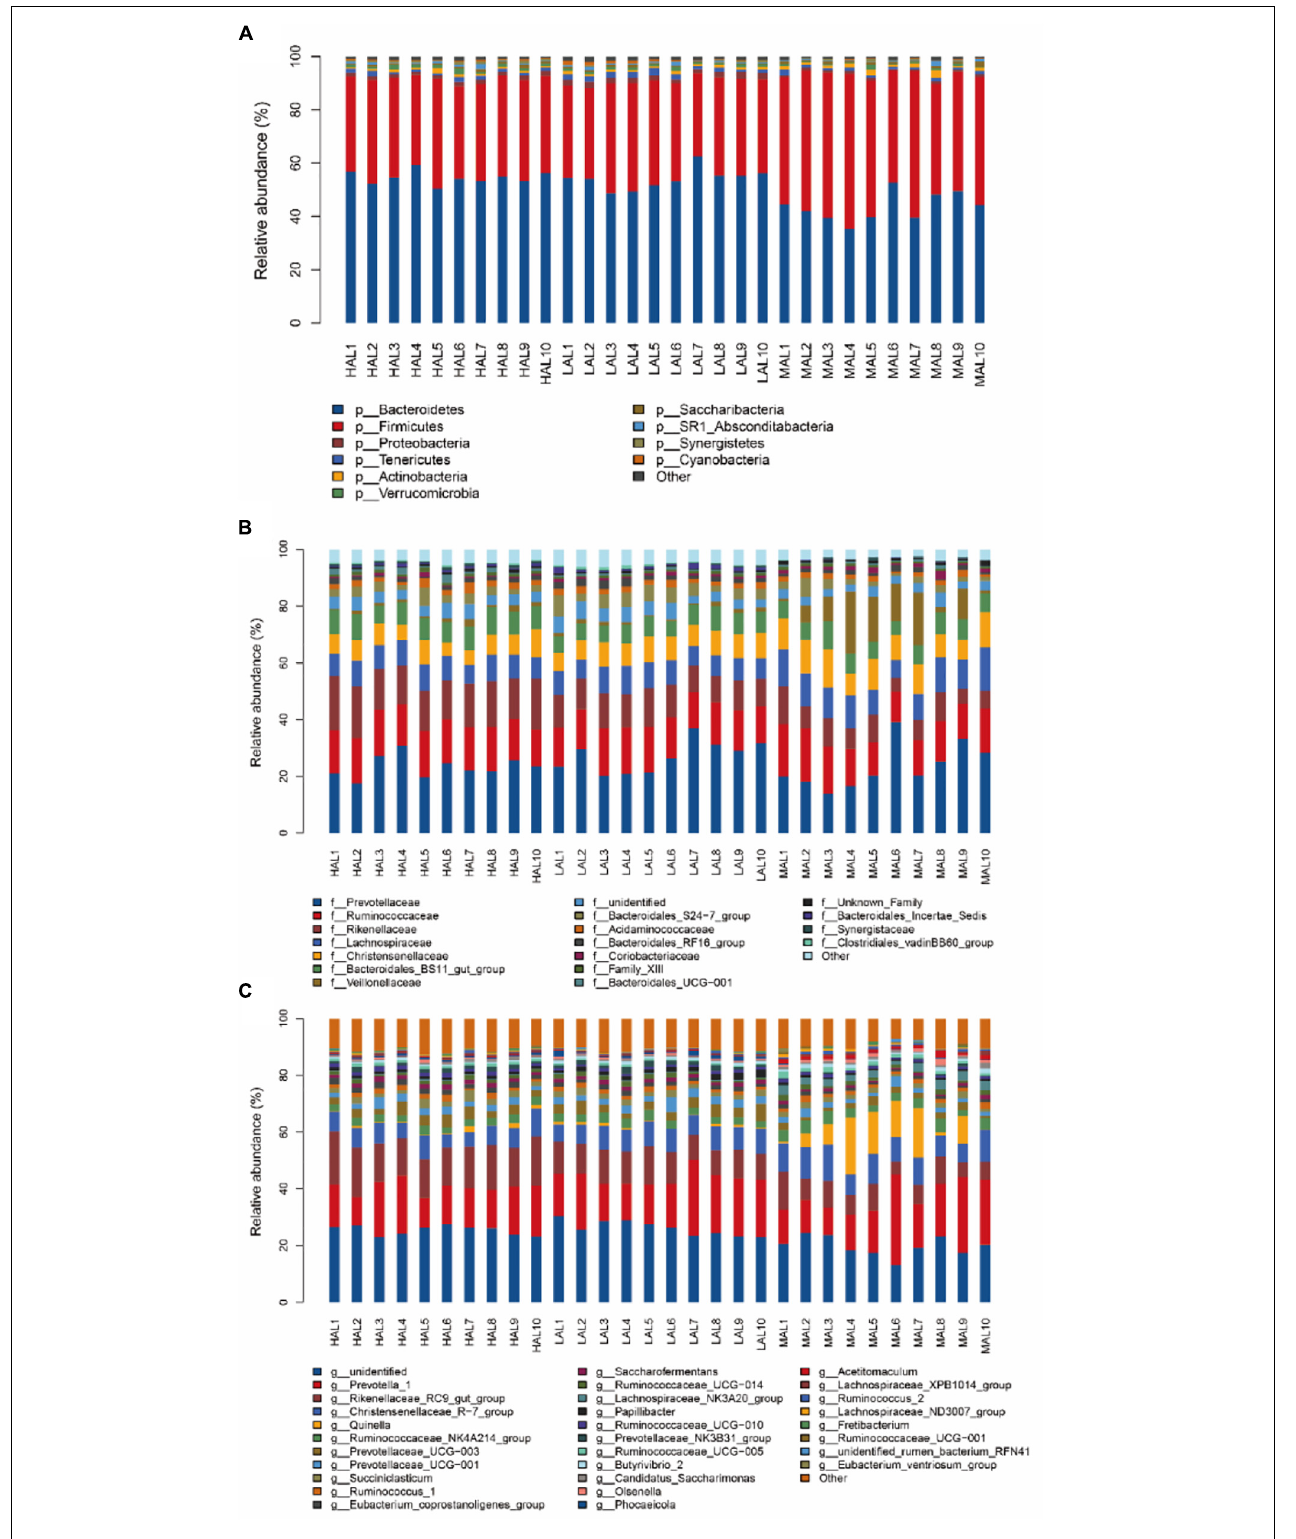
FIGURE 2 | Compositional profiles of rumen microbiota from yaks inhabiting regions located at distinct altitudes. (A) Phylum level, (B) family level, and (C) genus level. HAL, high-altitude region (Zhongba County, Xigatse City; 4,800 m); MAL, medium-altitude region (Nagqu City; 4,500 m); LAL, low-altitude region (Dangxiong County, Lhasa City; 3,800